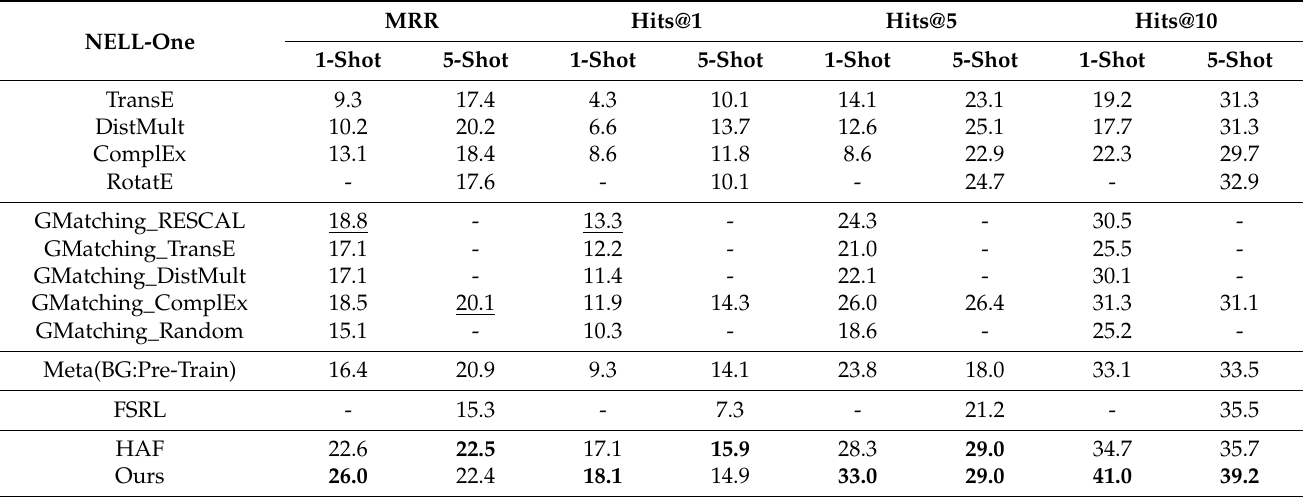
Table 1. The 1-shot and 5-shot experimental results on the NELL-One dataset. Underline represents the best experimental result of GMatching, and the numbers in bold represent the best experimental results of all methods.